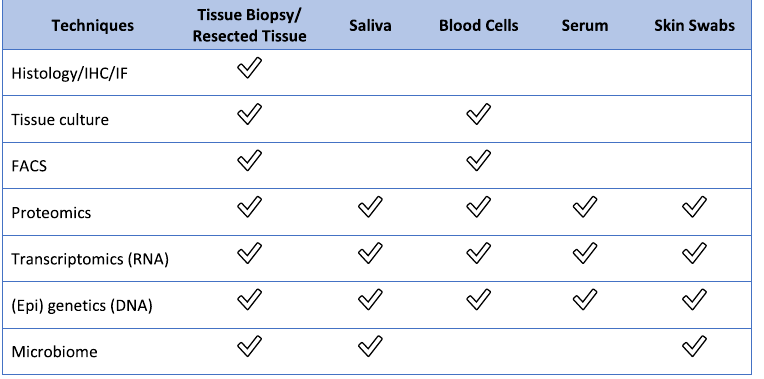
Figure 2. Analysis techniques possible for collected biospecimens. Checks denote whether each analysis technique can be performed with a collected